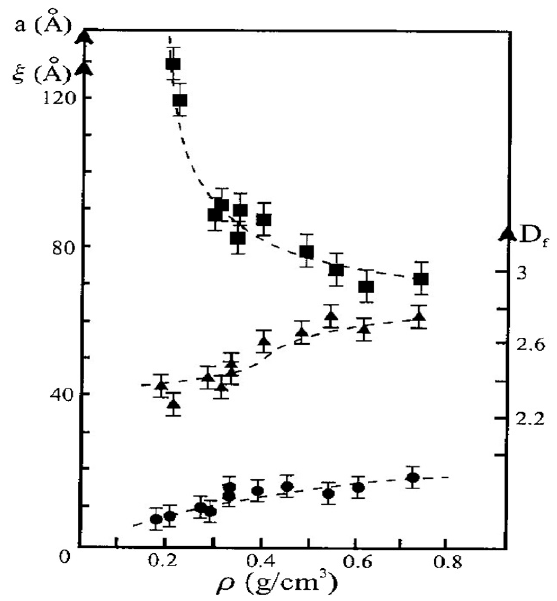
Figure 10. ξ (squares), a (circles) and Df (triangles) evolution versus the bulk density for the sin- tered aerogels set (from [53]).